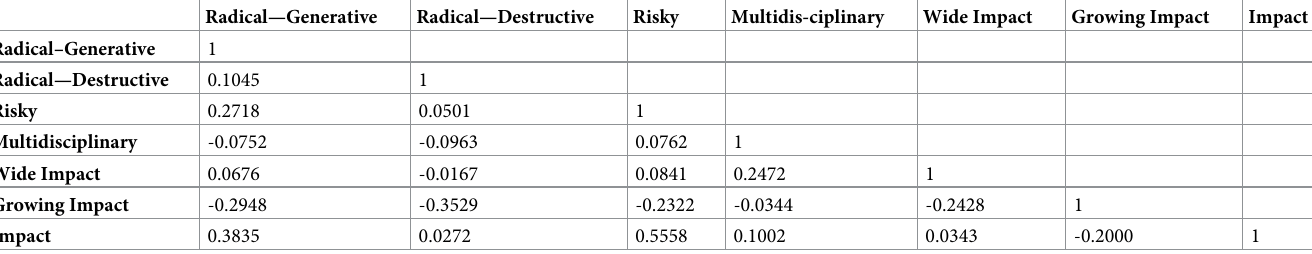
Table 4. Interrelations between the metrics for aspects of impact and transformativeness.